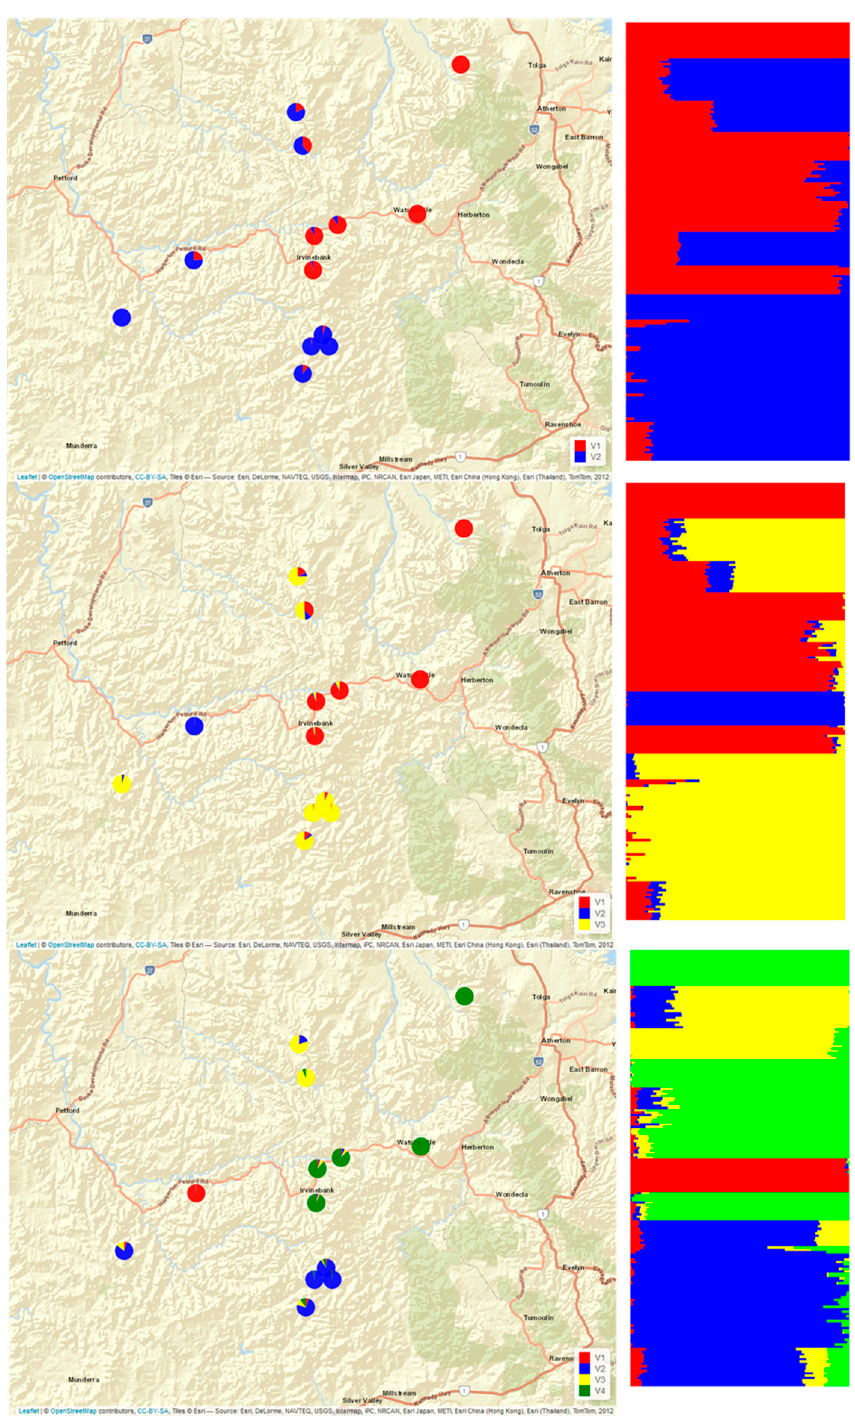
Figure A1. The assignment of ancestry coefficients of each individual sample inferred with snmf ( top , K = 2; middle , K = 3 and bottom , K = 4) are illustrated here by site using the pie diagrams on the map on the left hand side and the bar plot on the right hand side. Samples on the bar plot are ordered according to latitude and thus largely align with that of the pie diagrams on the map on the left.